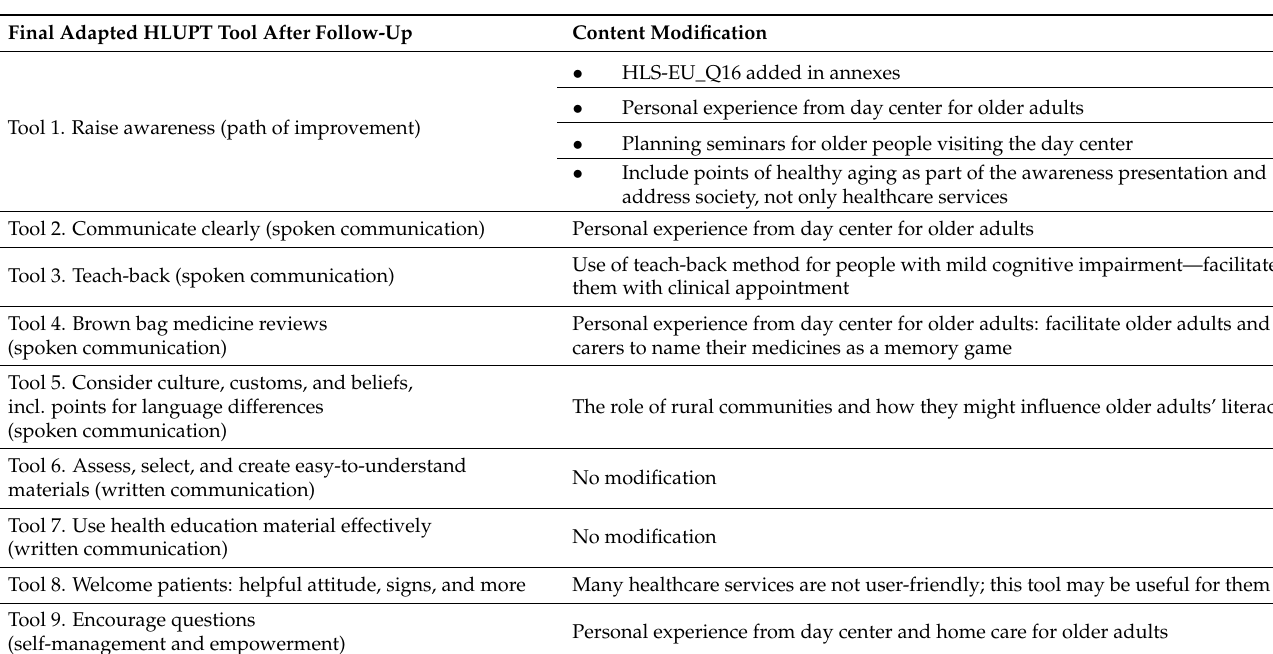
Table 6. Final adapted HLUPT for healthcare professionals working with older